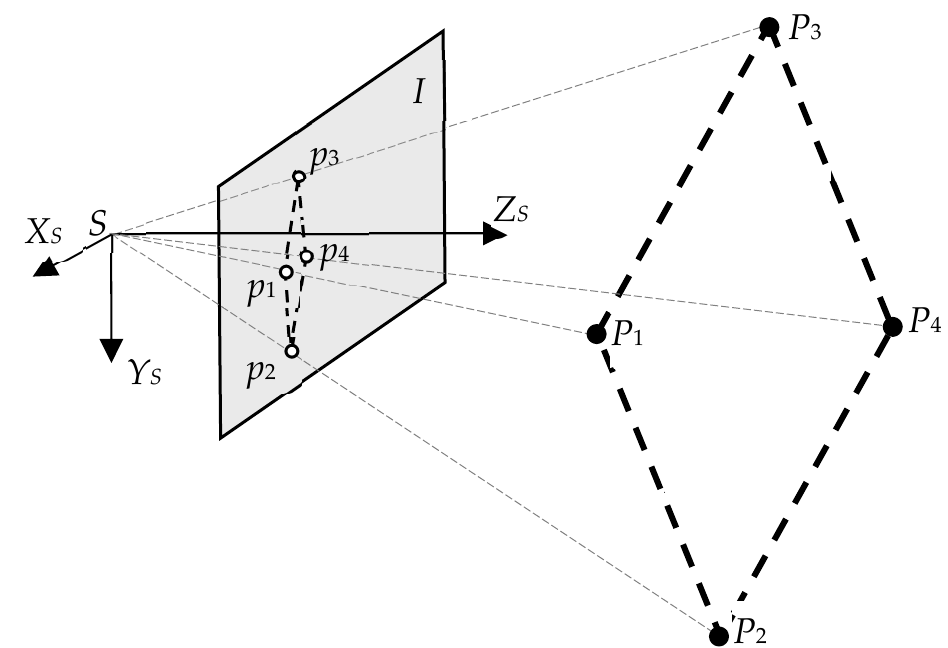
Figure 2. A parallelogram’s four vertices and their corresponding projections.